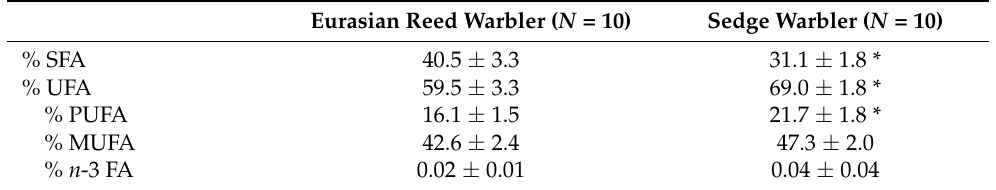
Table 2. Subcutaneous fatty acid composition (%) and molecular structure for Eurasian Reed and Sedge Warblers obtained by 1H Nuclear Magnetic Ressonance (RMN). Values are means ± SE ( N = 10). Significant differences between species are indicated by an asterisk ( t -test, * P < 0.05). FA: fatty acids; SFA: saturated fatty acids; UFA: unsaturated fatty acids; PUFA: polyunsaturated fatty acids; MUFA: monounsaturated fatty acid; n -3 FA: omega-3 fatty